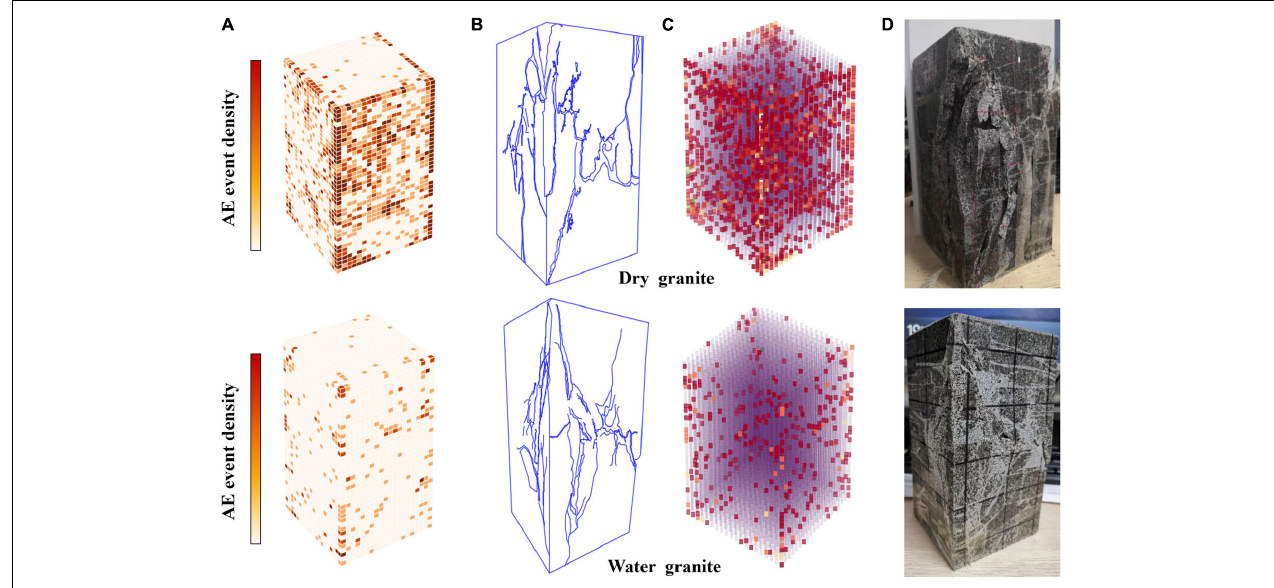
FIGURE 11 | Spatial distribution of AE event density and failure types of saturated water or dry granite are shown, and the density of AE events is directly proportional to the color depth of the cell cube. (A) Surface density distribution of AE event location results; (B) Granite crack growth and fracture mode; (C) Spatial density distribution of AE event location results; (D) Samples. The AE events in the process of granite damage caused by water are significantly reduced.